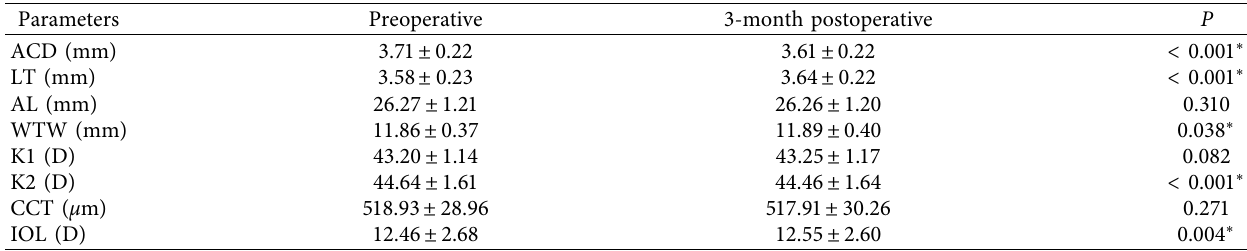
Figure 2: The IOLMaster images of a 28 year-old woman. The anterior surface of the right eye’s lens (above) was accurately identified by IOLMaster, while in the left eye (below), the anterior surface of ICL was mistaken as the anterior surface of lens. Table 2: The biometric parameters measured by IOLMaster excluding 11 misjudged eyes.